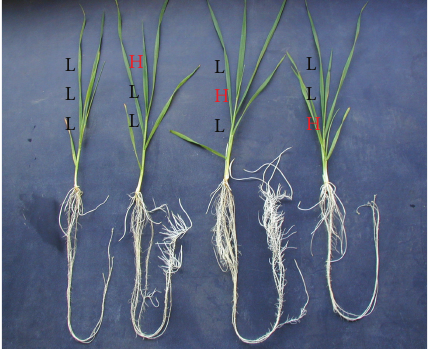
Figure 3: Effects of exogenous Ca supply during, before, and after 100 𝜇 M Al treatment on root regrowth in wheat plants at the recovery phase (7 d treatment without Al). Three letters either L and/or H indicate three weeks and Ca level (L = 250 𝜇 M, H = 2500 𝜇 M).